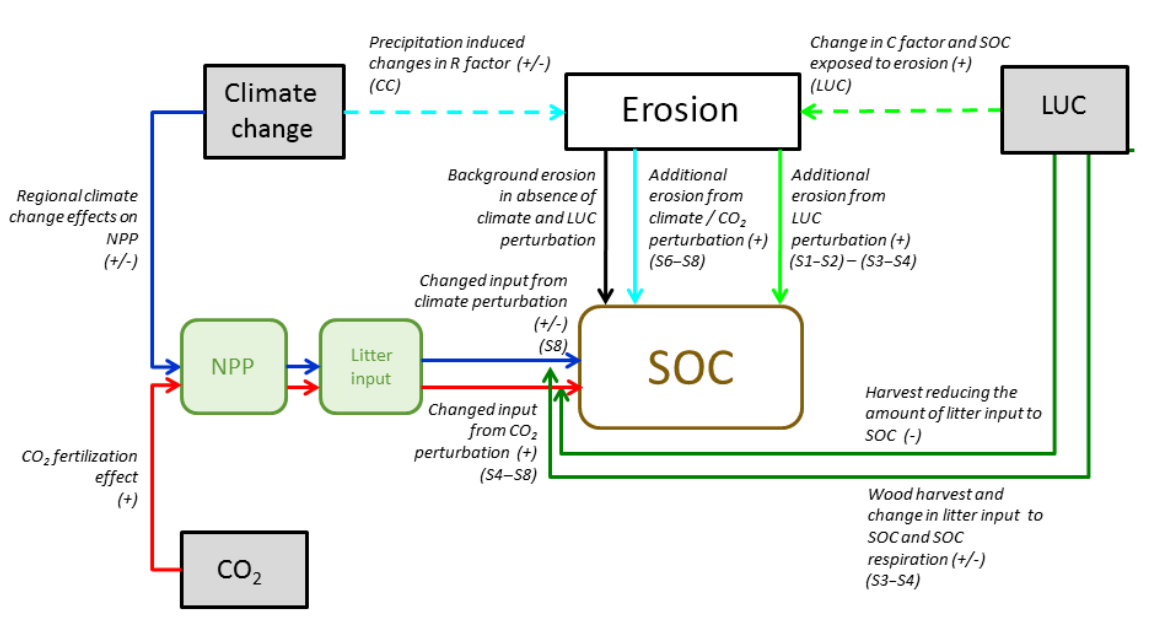
Figure 3. Conceptual diagram of SOC affected by erosion in the presence of other perturbations of the carbon cycle, namely climate variability, increasing atmospheric CO 2 concentrations, and land use change. A separation of these components and of the role of erosion is obtained with the factorial simulations (S1–S8), presented in Table 1.